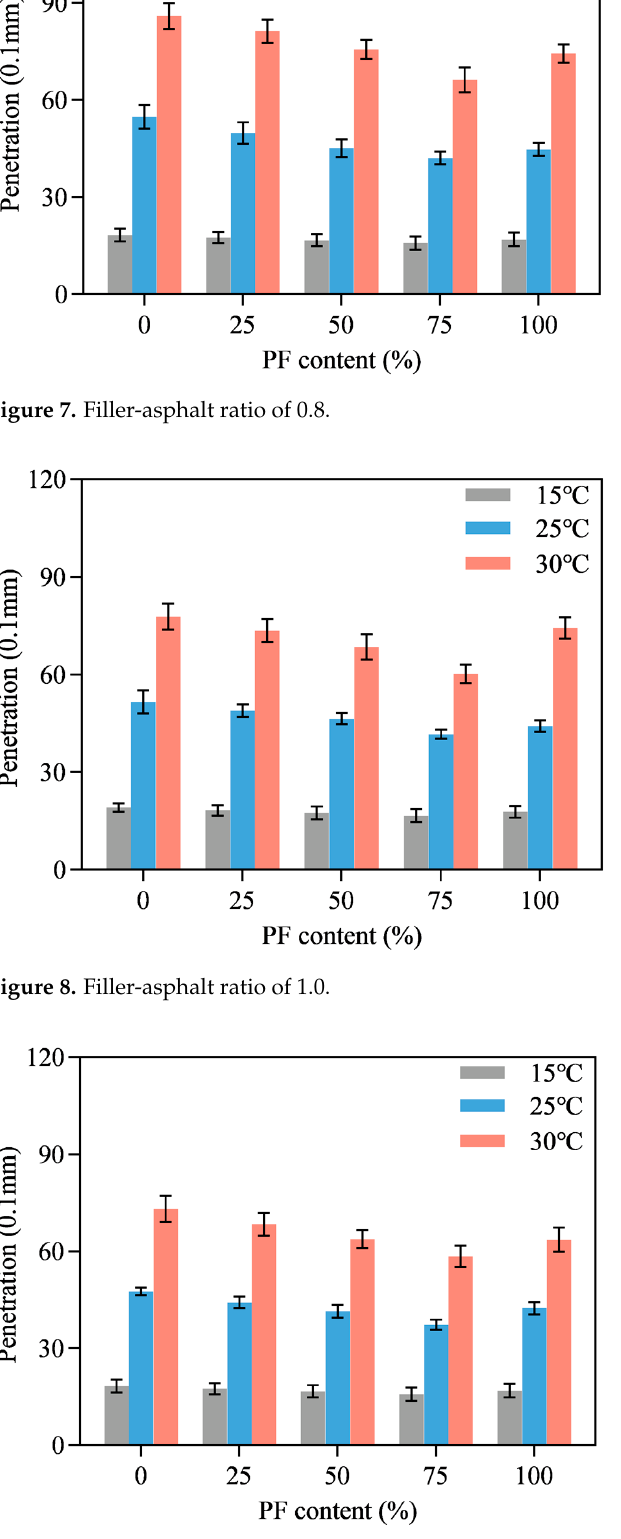
Figure 9. Filler-asphalt ratio of 1.2.